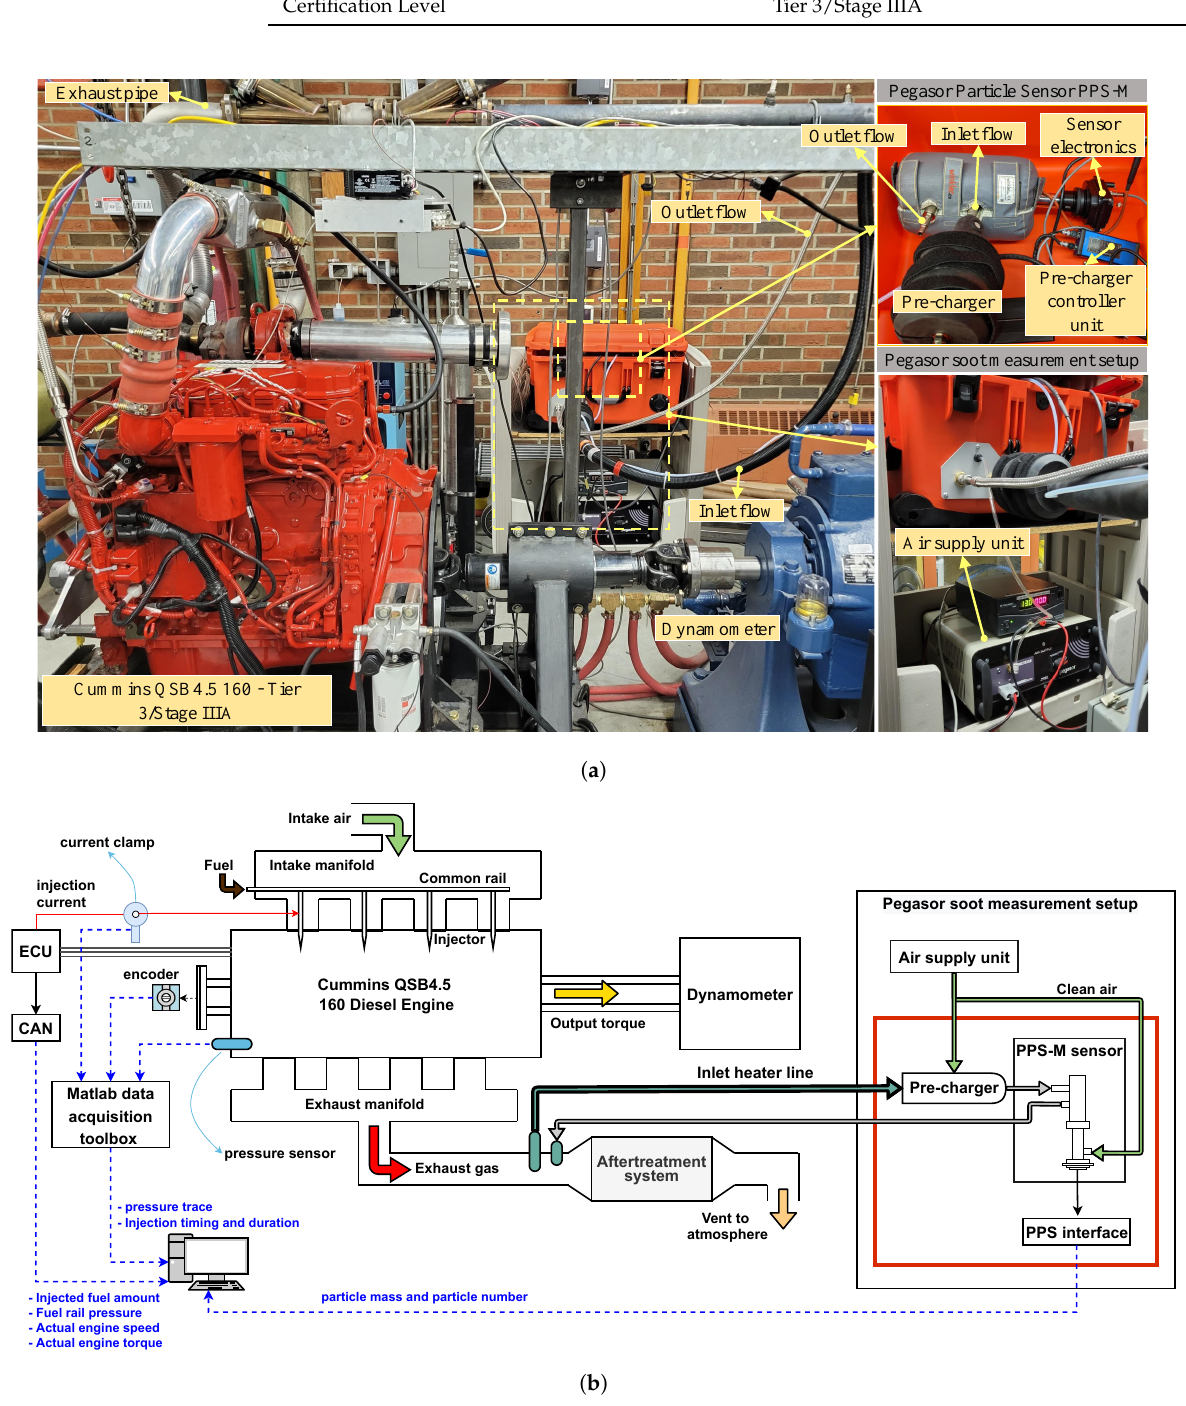
Figure 1. Diesel engine with soot measurement experimental setup. ( a ) Experimental setup. ( b ) Schematic of experimental